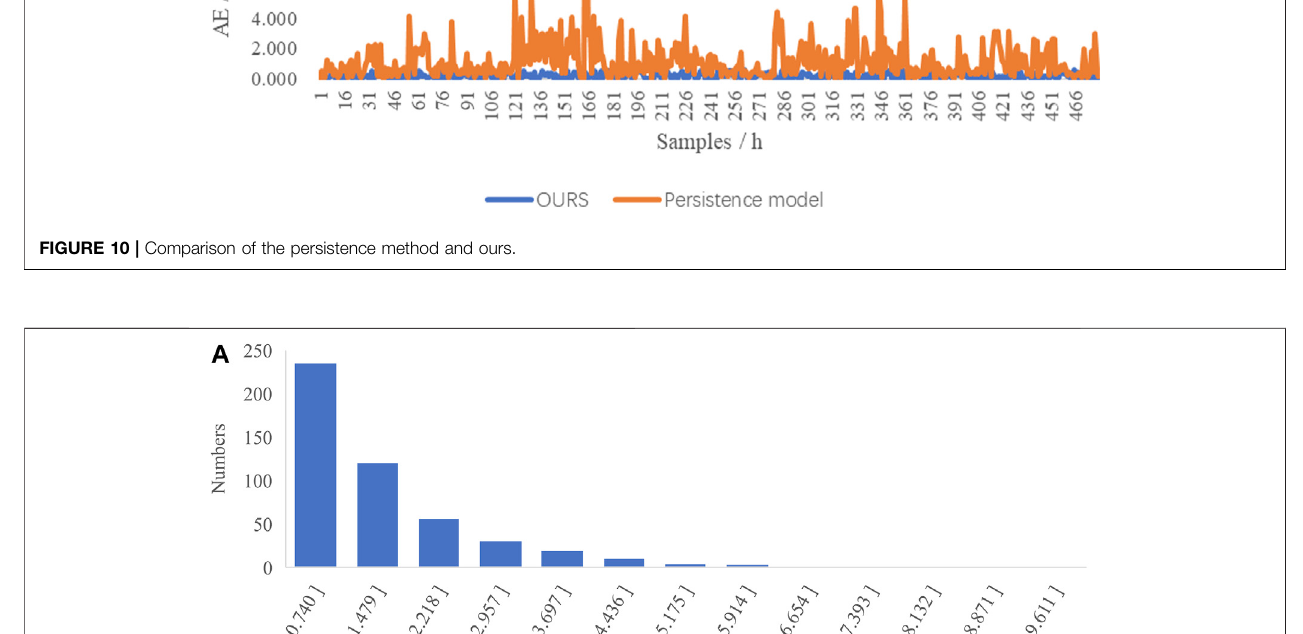
Frontiers in Earth Science |